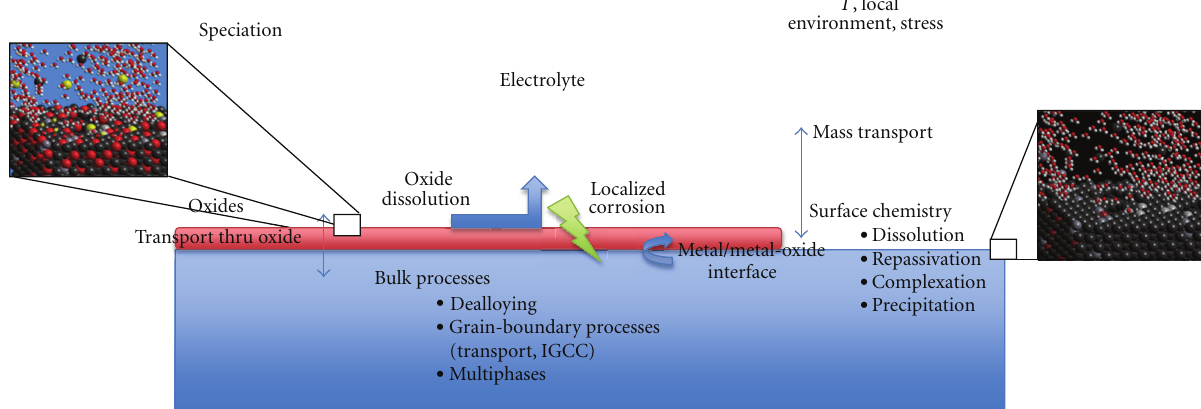
Figure 1: Schematic of the materials/environment interface. Features relevant to corrosion are labeled. Reproduced from